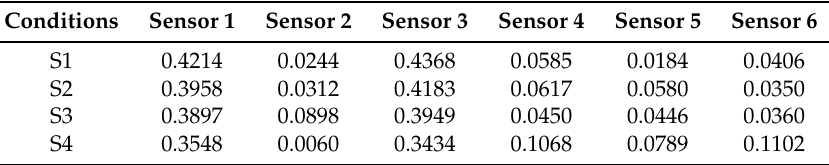
Table 3. Group weight values of six sensors under four